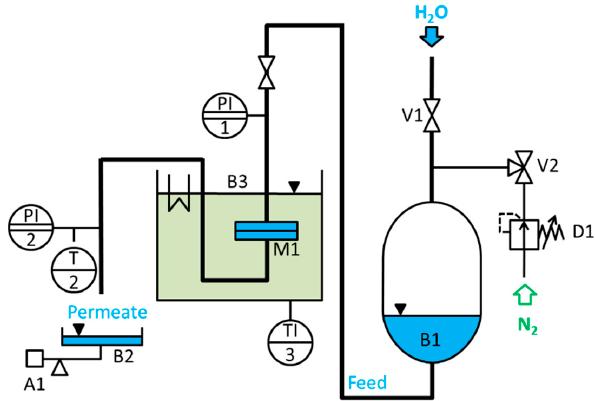
Figure 11. Permeance measurement device (dead-end mode).